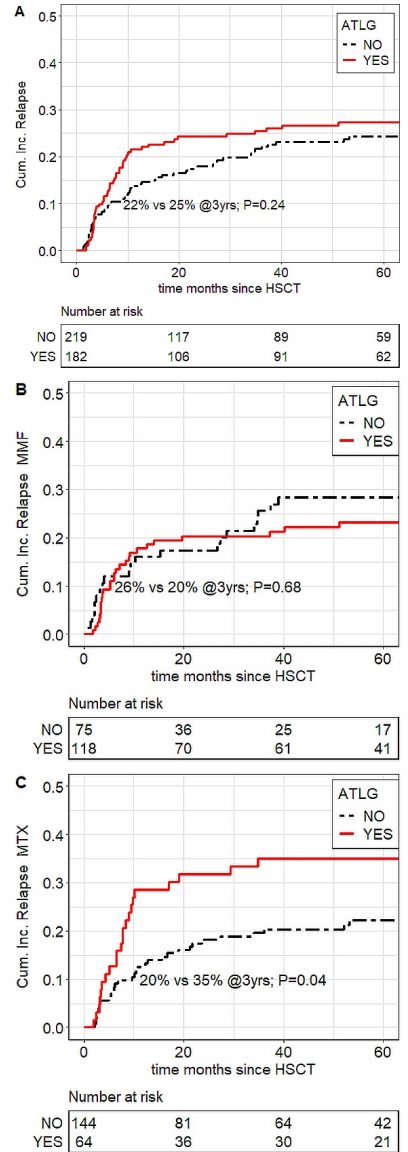
Figure 5. Cumulative relapse incidence. Red line, ATLG; black line, no ATLG. ( A ) Entire cohort. ( B ) MMF subgroup. ( C ) MTX